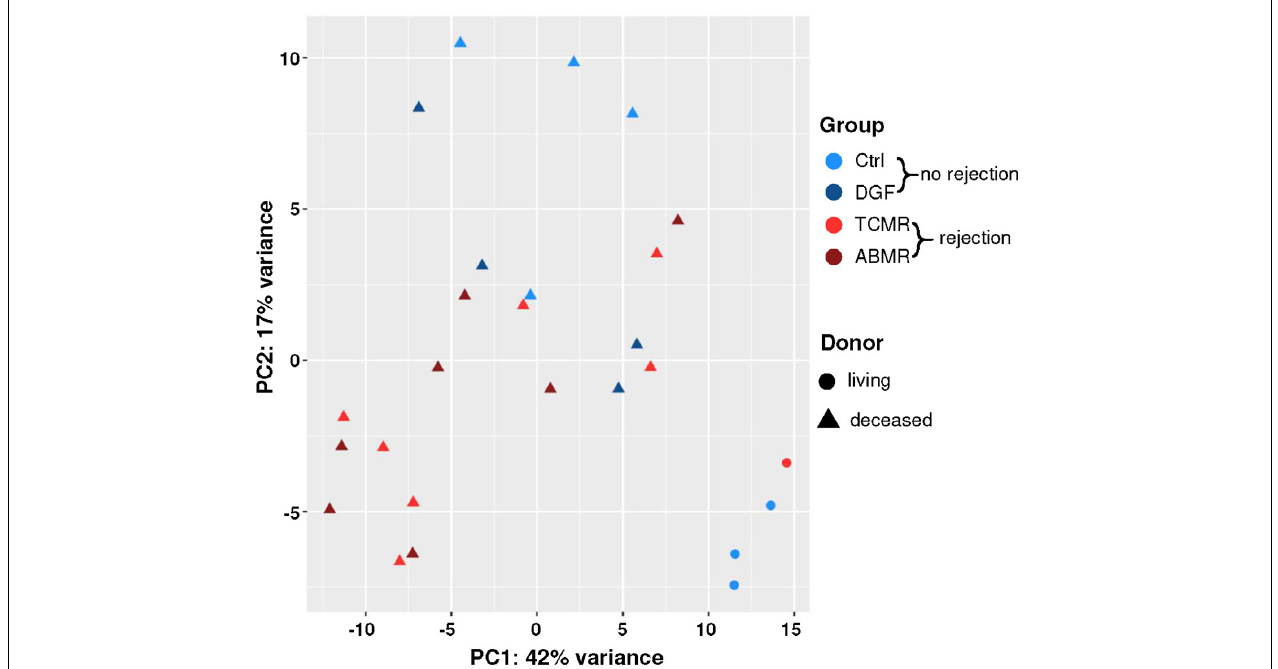
FIGURE 1 | Principal component analysis (PCA) plot of NanoString expression data. The plot of the first two principal components (PC1 and PC2), calculated from the expression data of the 100 genes with the highest variance across all 26 samples. Axis labels report the percentage of total variance explained by each component. Biopsies without later rejection were indicated with blue symbols [Ctrl = light blue; delayed graft function (DGF) = dark blue] and those with later rejection with red symbols [T-cell mediated rejection (TCMR) = bright red, antibody-mediated rejection (ABMR) = dark red]; living donors were denoted using circles and deceased donors using